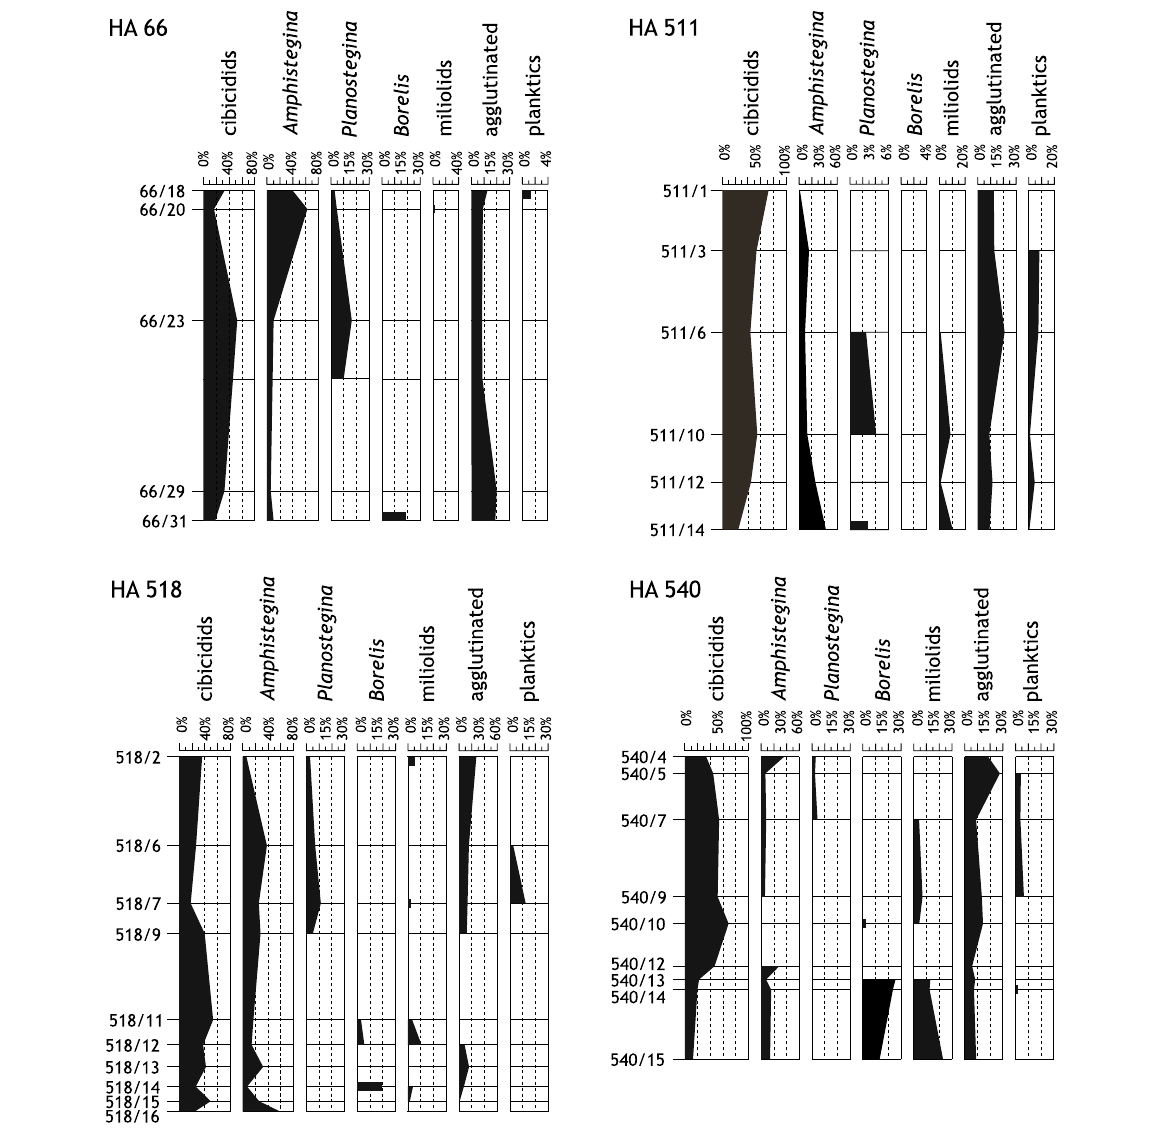
Fig. 9 Distribution of selected foraminiferal taxa in thin sections of the 4 cores HA 66, HA 511, HA 518, and HA